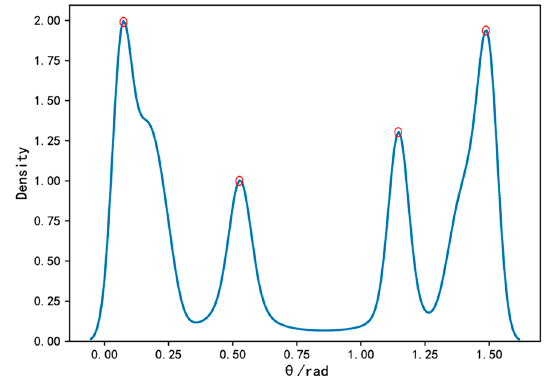
Figure 4. The angular probability density distribution.